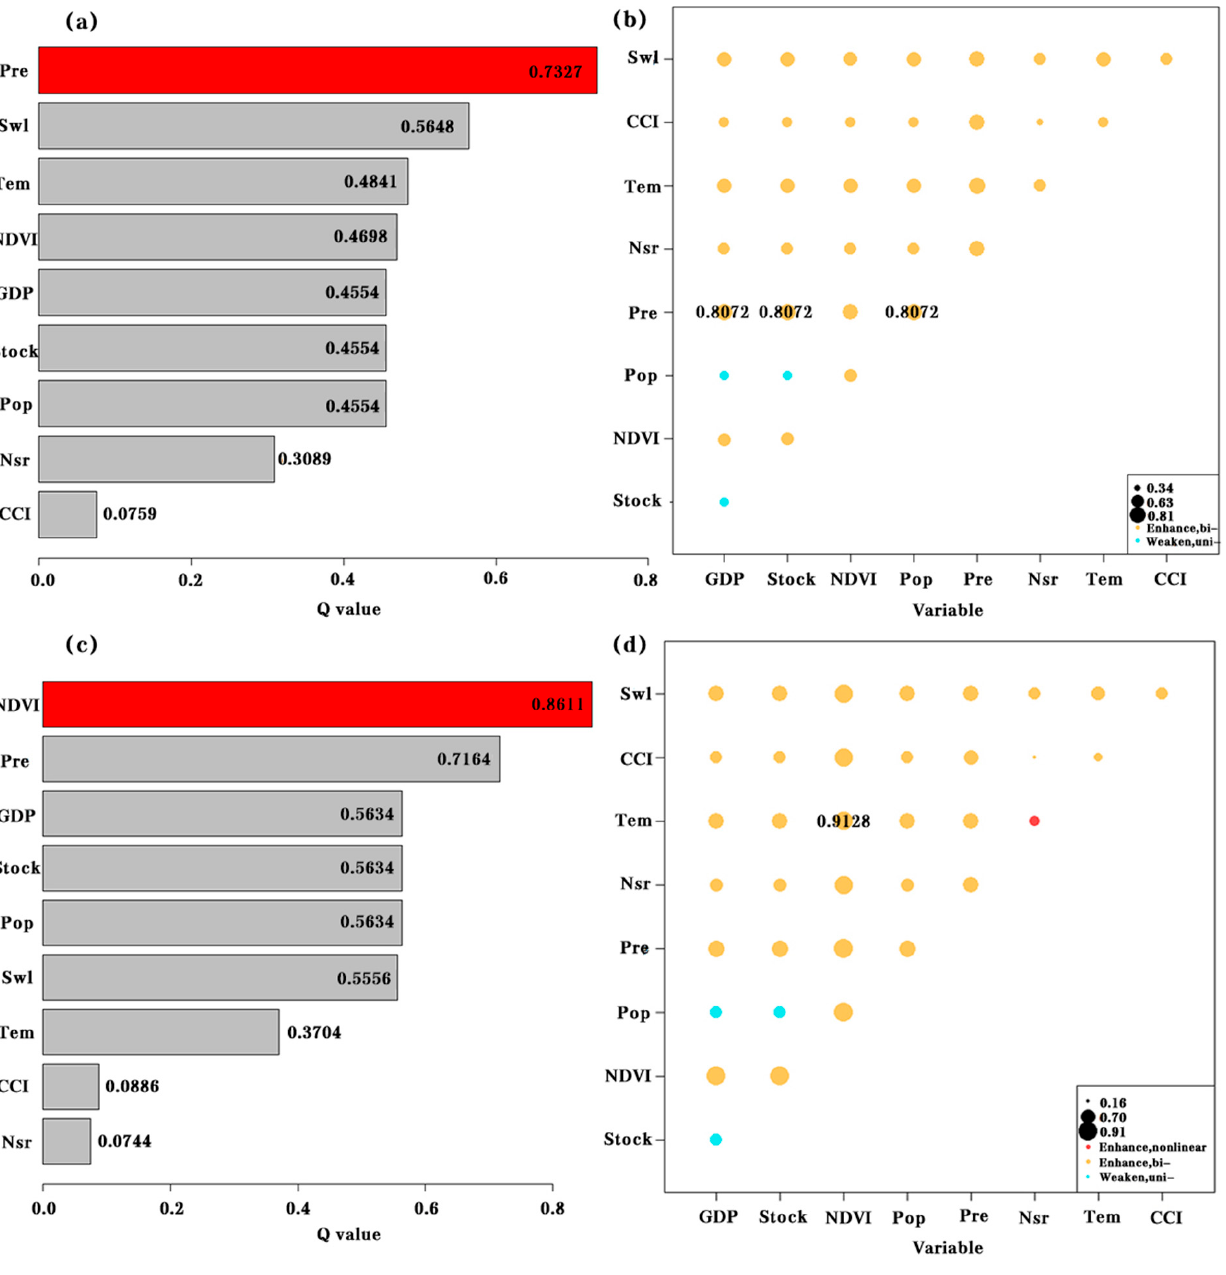
Figure 9. ( a , b ) Results of the factor detector and interaction detector between climate factors, human factors and average ET in Mongolia from 2001 to 2020; ( c , d ) results of the factor detector and interaction detector between climate factors and human factors and average ET in the growing season of Mongolia from 2001 to 2020.